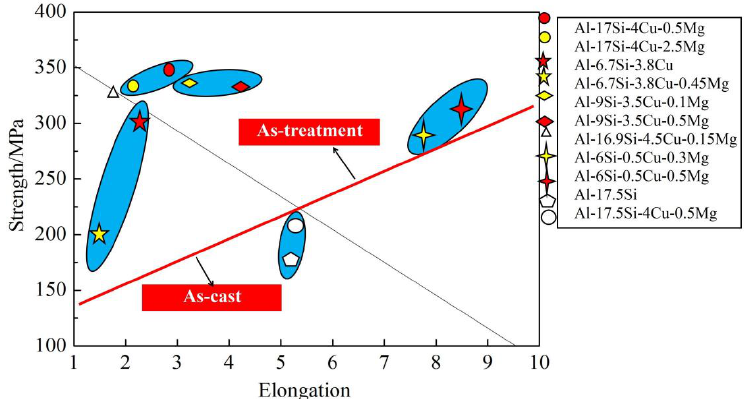
Figure 11. Mechanical performances compared among different Al − Si alloys.